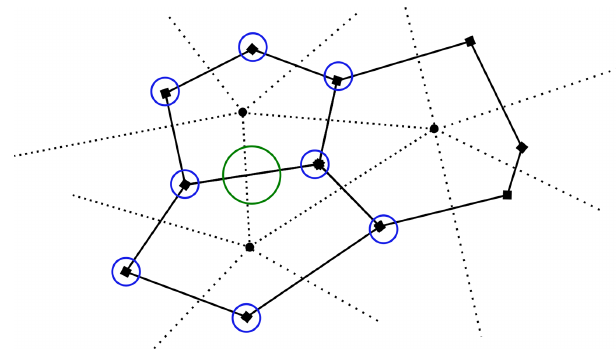
Figure 4. A diagram of the stencil v ∈ CVE (e) = VE (i 1 ) ∪ VE (i 2 ) with (i 1 ,i 2 ) = CE (e) , which is simply the union of all vertices v (blue) in the cells on either side of edge e